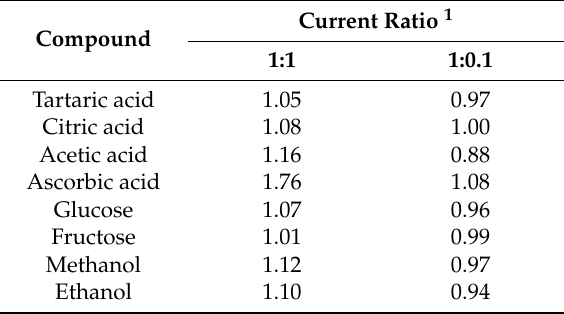
Table 1. Interference tests on various compounds for the assay of